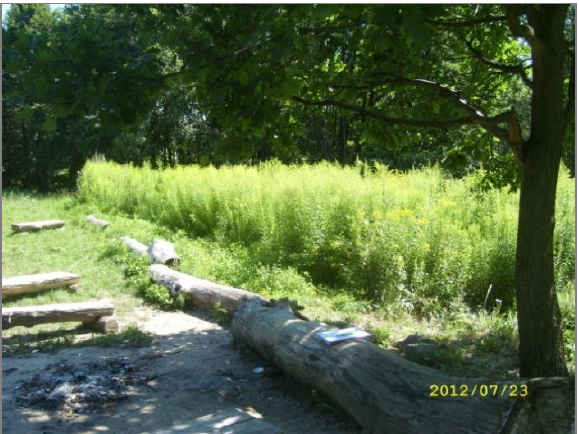
Fig. 3. A patch of Impatiens parviflora on the bottom of the Ślepiotka valley ( M. Frelich , 2012)